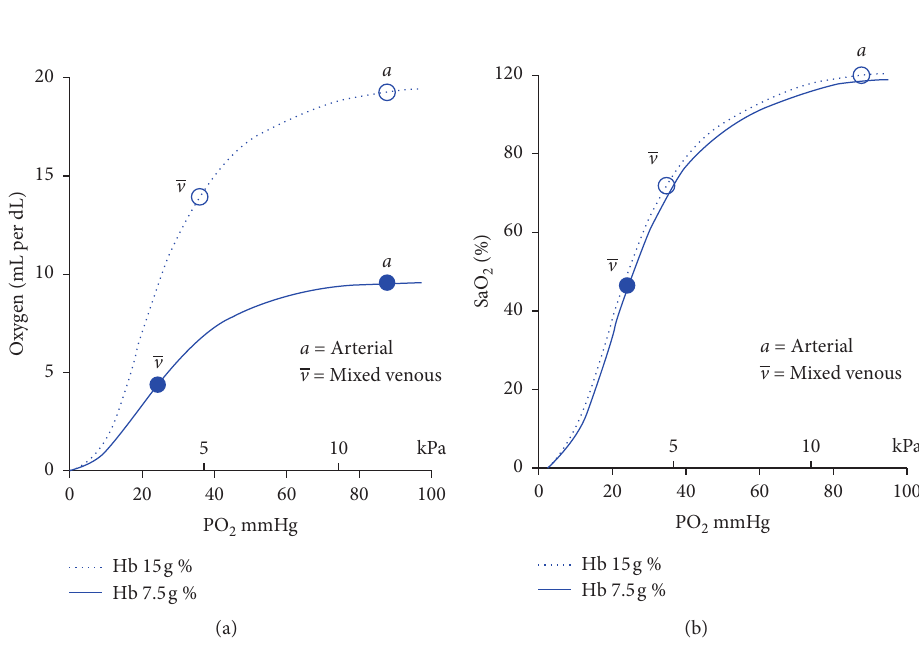
Figure 4: Relation of anemia to oxygen content and oxygen-haemoglobin dissociation curve